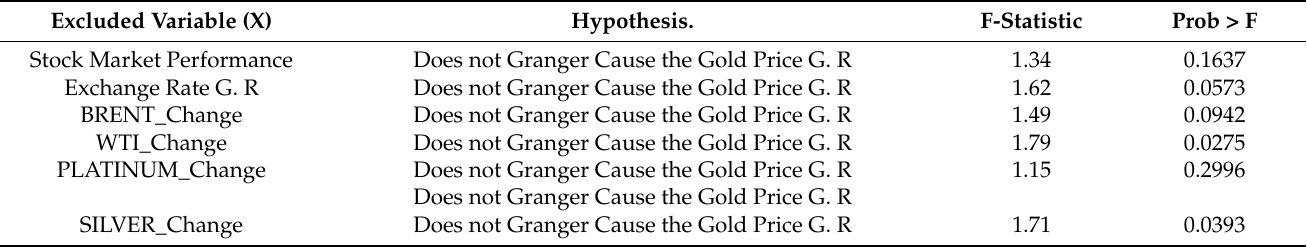
Table A12. Granger Causality test related to the Gold Price G. R (Regression with Driscoll–Kraay Approach).